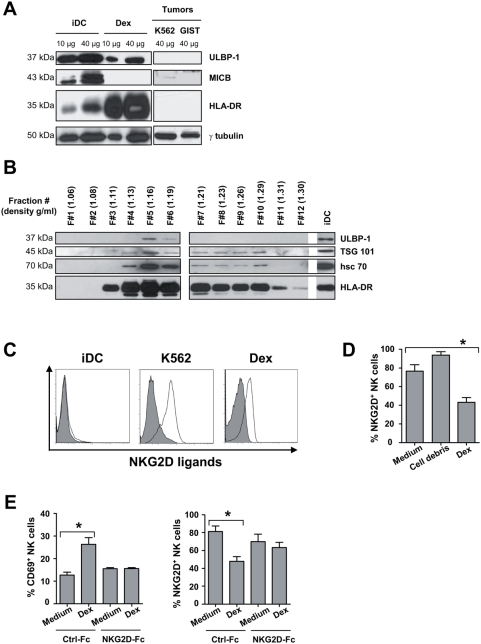
Human Dex harbour functional NKG2D ligands.A–B. Immunoblot detection of NKG2D ligands on Dex. (A) 10–40 µg of protein lysates from immature DC (iDC), Dex or tumor cells (K562, GIST) were assayed in western blot analyses using anti-ULBP-1 and MICB Abs on whole protein lysates (A) (this result was similar in 6 Dex preparations from 6 different healthy donors) or on each fraction of distinct density (B) following ultracentrifugation of 400 µg of Dex proteins on a continuous density gradient. Controls included anti-HLA-DRα, TSG 101, hsc 70 Abs and anti-γ tubulin Abs are also depicted. Molecular weights are indicated on the left lane. Note that the density of the ULBP-1 positive Dex fractions is approximately 1.16 to 1.19 g/ml i.e. the assumed density flotation of Dex. C. Dex express cell surface NKG2D ligands. Flow cytometry analyses of the surface expression of NKG2D ligands (empty histograms) on beads coated-Dex using rhNKG2D-Fc chimera or a mix of anti-human MICA/B, ULBP-1, ULBP-2 and ULBP-3 mAbs and appropriate secondary Abs. Similar stainings of iDC and K562 cells (a negative and positive control respectively). Filled histograms represent stainings with isotype matched mAbs. D. Engagement of NKG2D receptors on NK cells triggered by Dex. NK cells were incubated 40 hrs with medium or 10 µg autologous Dex or irrelevant pelleted proteins (cell debris) coated onto MaxiSorp™ wells, and then stained with anti-CD3 APC, anti-CD56 CyC, anti-NKG2D PE mAb. Flow cytometry analyses revealed the mean % (±SEM) of NKG2D expressing NK cells in three independent experiments performed in triplicate wells. E. NKG2D-dependent NK cell activation by Dex in vitro. Identical setting as in D. but using rhNKG2D-Fc fusion proteins or Ig-Fc controls to determine CD69 (left panel) and NKG2D (right panel) expression on NK cells in flow cytometry analyses. * p<0.05.